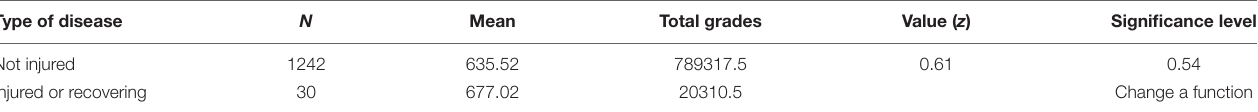
TABLE 5 | Differences in the psychological responses to the COVID-19 pandemic type of disease. Type of disease